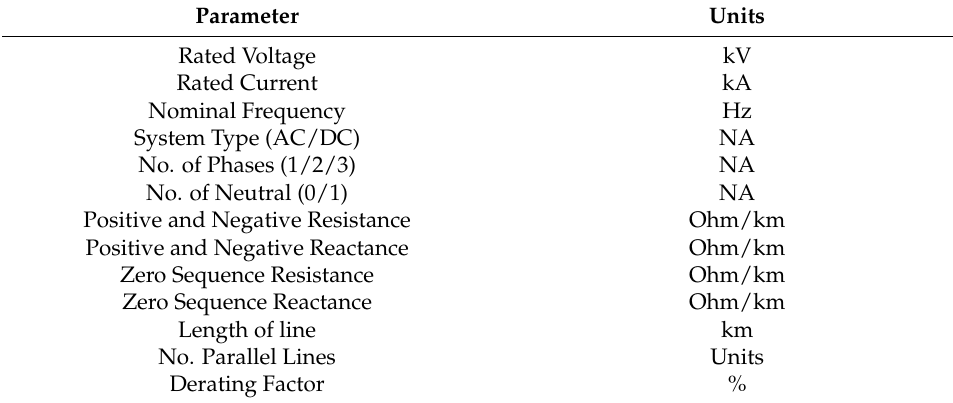
Table 3. Input parameters to model